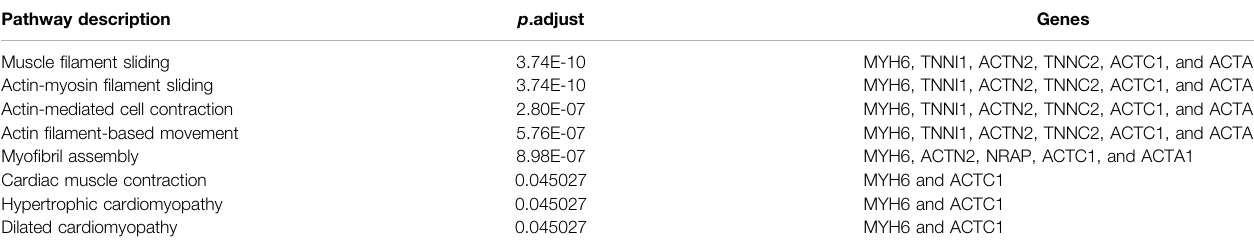
TABLE 3 | GO and KEGG pathway enrichment analysis of DEGs in two